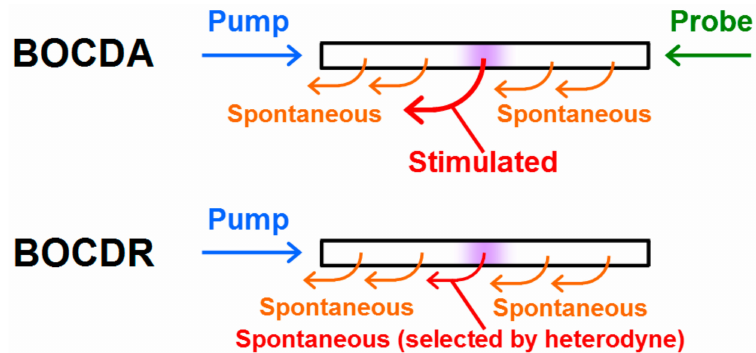
Figure 3. Comparison of the operating principles of BOCDA and BOCDR.